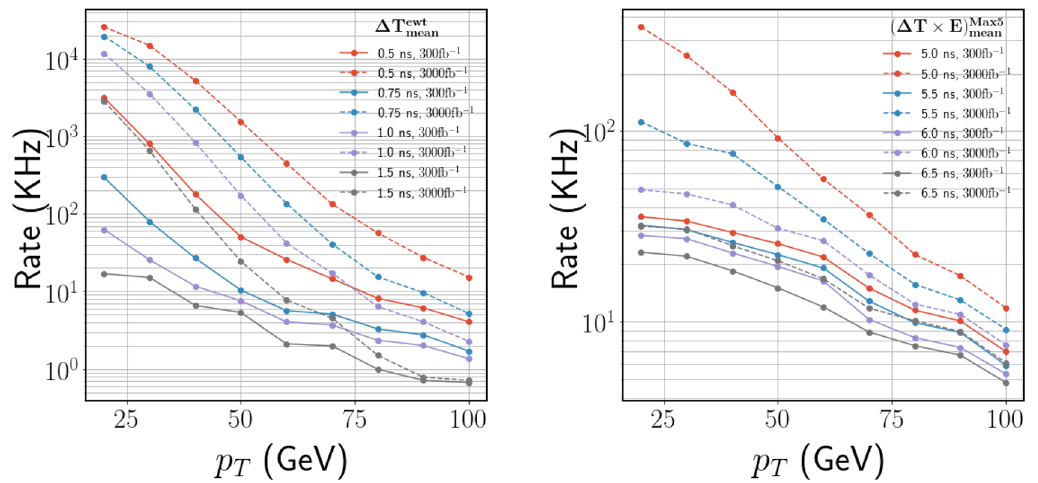
Figure 10 . Rate of background events as a function of jet p T with varying cuts on the ∆ T Ewt ( left ) and (∆ T × E ) max 5 ( right ) timing of the jet for ECAL timing resolutions corresponding to mean 300 fb − 1 and 3000 fb − 1 in the 140 PU